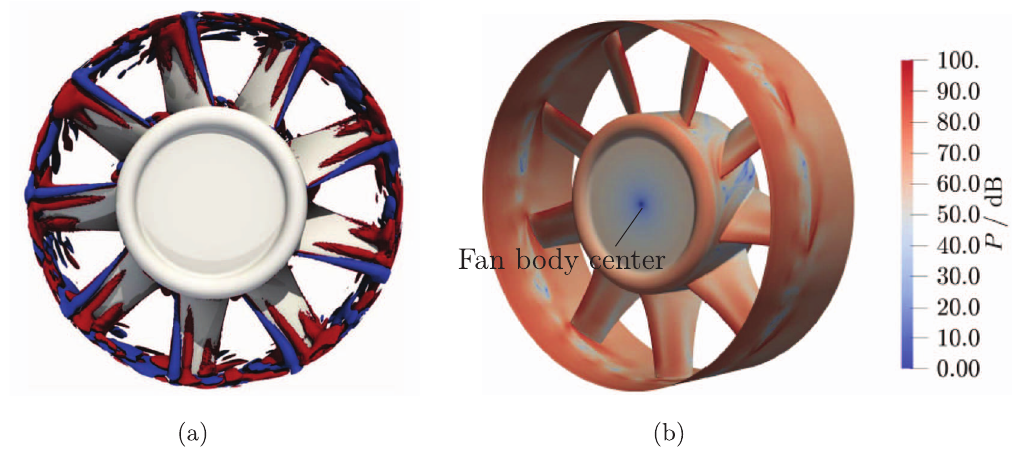
Figure 3. Constant iso surfaces of the acoustic power source terms at 220 Hz and surface source power levels obtained from aeroacoustic simulation of an unskewed fan, [34]. (a) Source strength iso surfaces at 220 Hz near f BPF . (b) Surface source acoustic power levels in dB, calculated stochastically in time